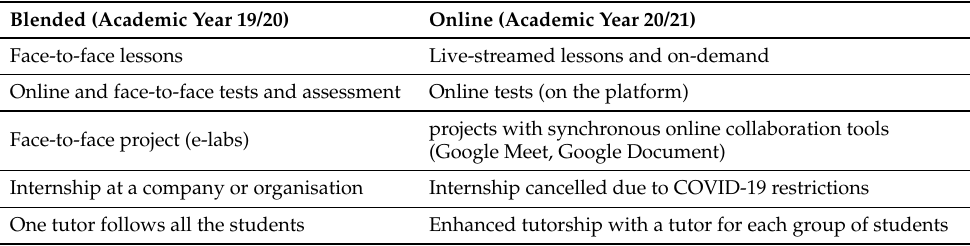
Table 1. The table shows the main changes between the two editions of the master’s